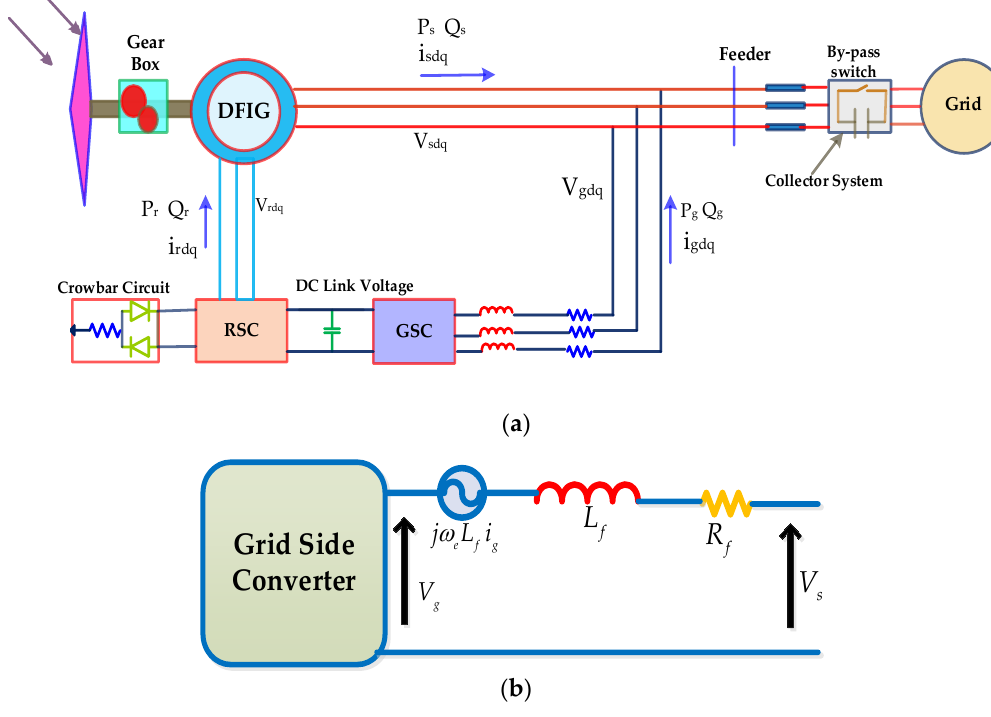
Figure 1. ( a ) Schematic diagram of wind energy doubly fed induction generator (DFIG) system. ( b ) Equivalent circuit of the grid side converter.